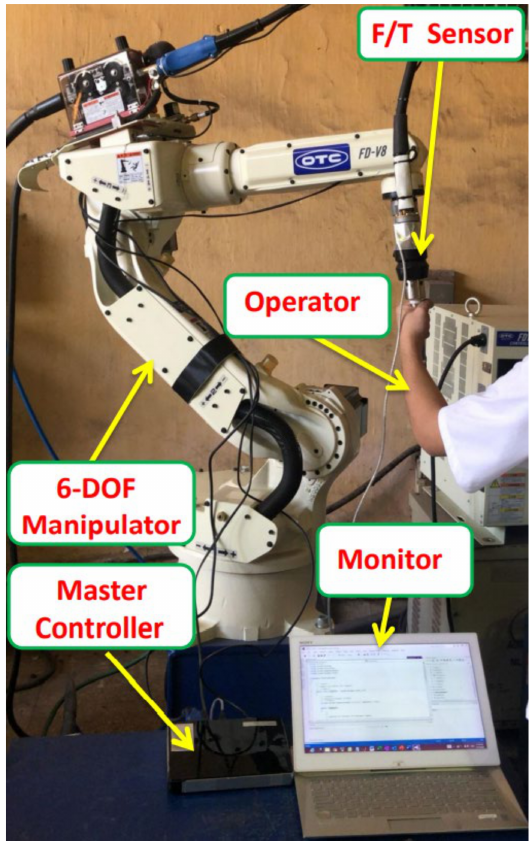
Figure 8. The experimental setup for teaching